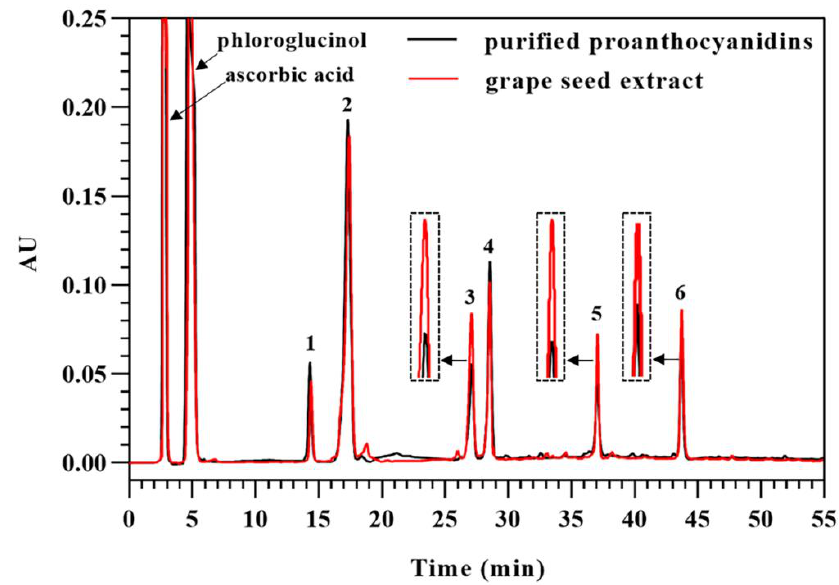
Figure 6. HPLC chromatograms of cleavage products from purified proanthocyanidins and grape seed extract following acid-catalysis in the presence of excess phloroglucinol. (1) catechin– phloroglucinol; (2) epicatechin–phloroglucinol; (3) catechin; (4) epicatechin gallate–phloroglucinol; (5) epicatechin; and (6) epicatechin